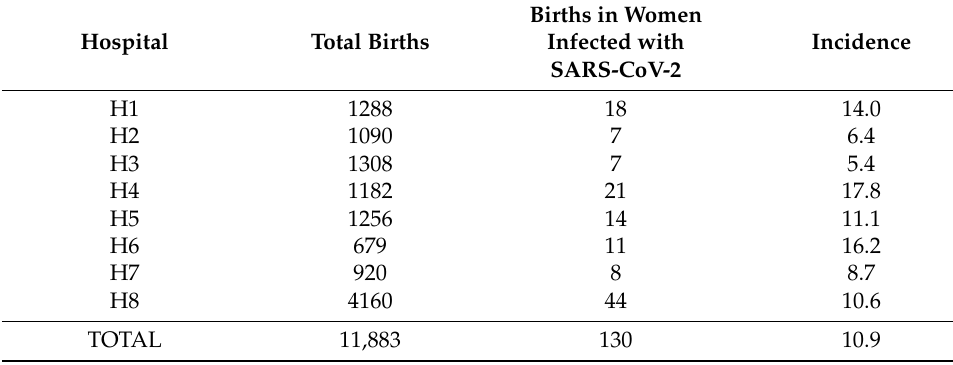
Table 2. Demographic characteristics of women infected with SARS-CoV-2 in the study. Study Variables